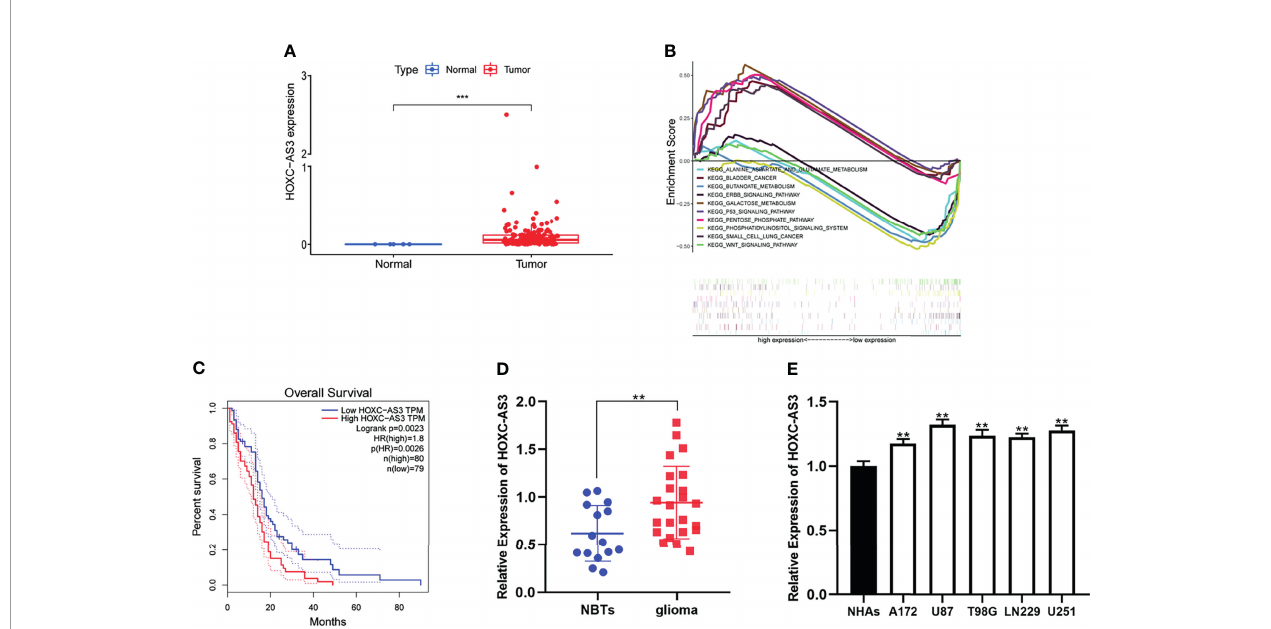
FIGURE 1 | HOXC-AS3 was upregulated in glioma and associated with poor prognosis. (A) The expression level of HOXC-AS3 in TCGA. (B) HOXC-AS3 associated pathways were investigated using gene set enrichment analysis (GSEA) by TCGA genes data. (C) The Survival Plots of HOXC-AS3 in GEPIA. (D) Expression of HOXC-AS3 in 15 normal brain tissues and 23 glioma tissues. (E) Expression of HOXC-AS3 in normal human astrocytes and glioma cell lines. Mann-Whitney test for (A) ; Log-rank test for (C) ; t-test for (D) ; one-way ANOVA and post hoc test for (E) . ***P < 0.001, **P <